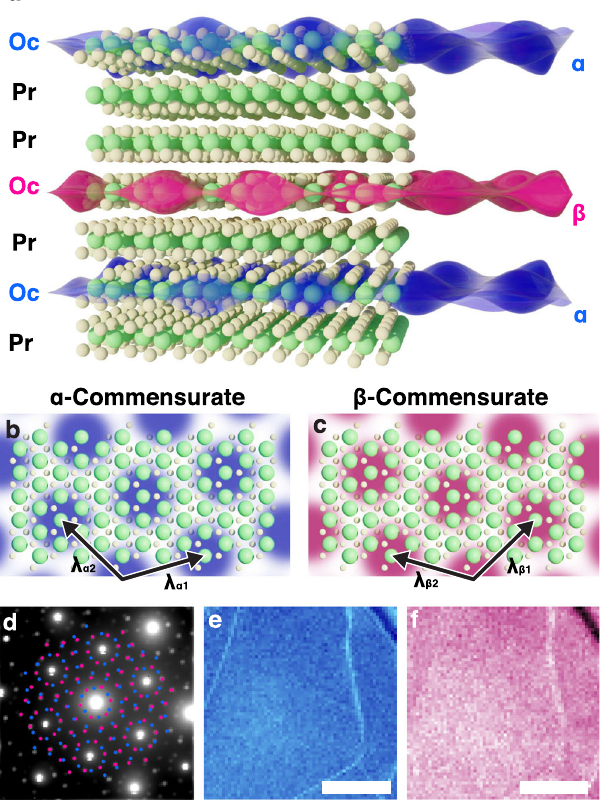
Fig. 1 Twinned, commensurate CDW at room temperature in ultrathin TaS 2 . a Schematic illustration of room-temperature, out-of-plane twinned, commensurate CDW in 1T-TaS 2 . Blue and red overlays depict CDW twins within octahedrally coordinated TaS 2 . Metallic prismatic polytypes isolate octahedral layers to stabilize tC-CDWs. b , c Twin superlattice structure illustrated for α and β C-CDW, respectively. d Average diffraction pattern of twinned, C-CDW state over (870 nm) 2 fi eld-of-view reveals two sets of superlattice peaks (marked with blue and red; unmarked image available in Supplementary Fig. S12a). e , f Nanobeam diffraction imaging from each set of superlattice peaks maps the coexistence of both CDW twins — expected for twinning out-of-plane. Scale bar is 300